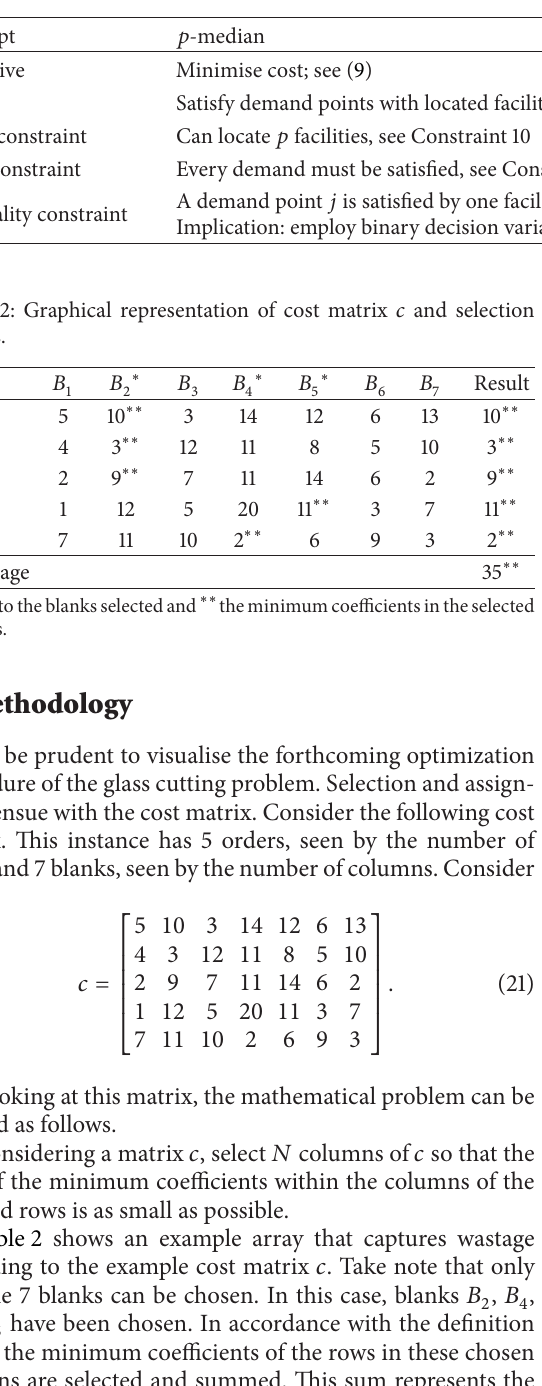
Table 1: Concept Comparison of the 𝑝 -median Problem to Glass Cutting Problem.